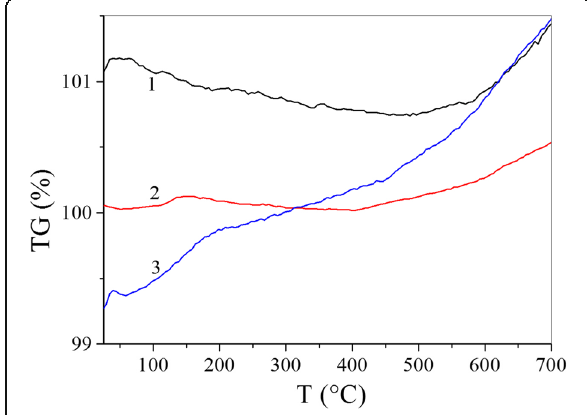
Fig. 4 Thermogravimetric curves of Cu-Ti ( 1 ), Cu-Ti 1 vol% MWCNTs ( 2 ) and Cu-Ti 3 vol.% MWCNTs ( 3 )